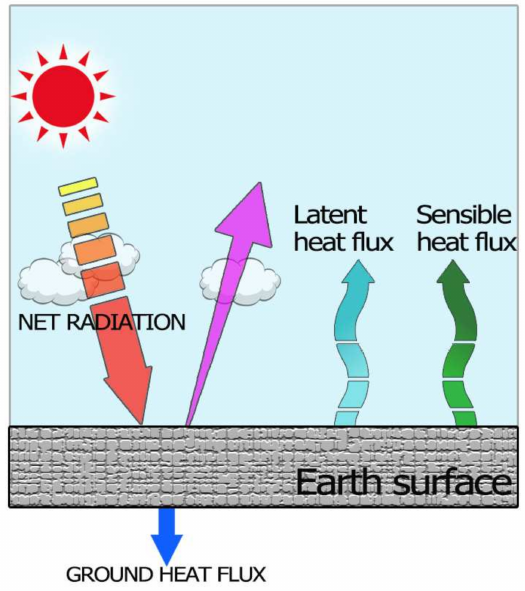
Figure 13. The diagram of surface energy